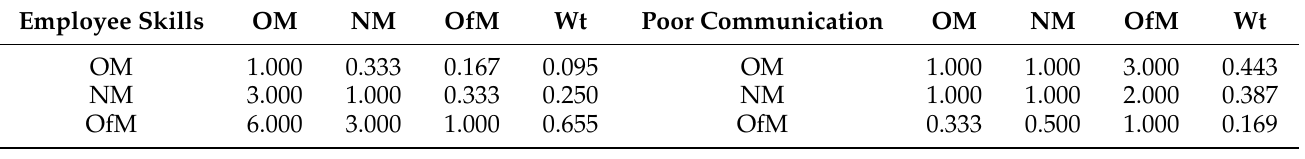
Table A2. Case study-2: Calculation of alternative preferences with respect to employee skills and poor communication. Employee Skills